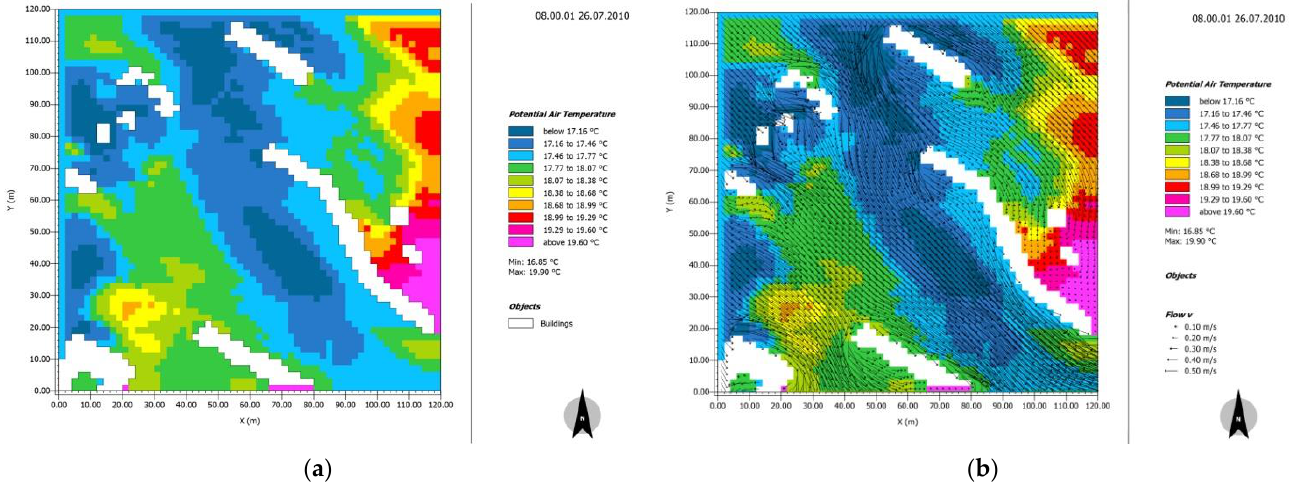
Figure 4. ( a ) T1 simulation for 8 a.m., 26 July 2010; ( b ) T1 simulation for 8 a.m., 26 July 2010 with flow (image generated by ENVI-met).